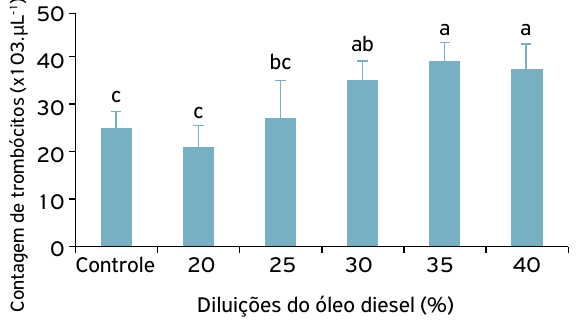
Figura 3. Contagem de trombócitos em juvenis de tilápia expostos a diferentes diluições de óleo diesel. Valores